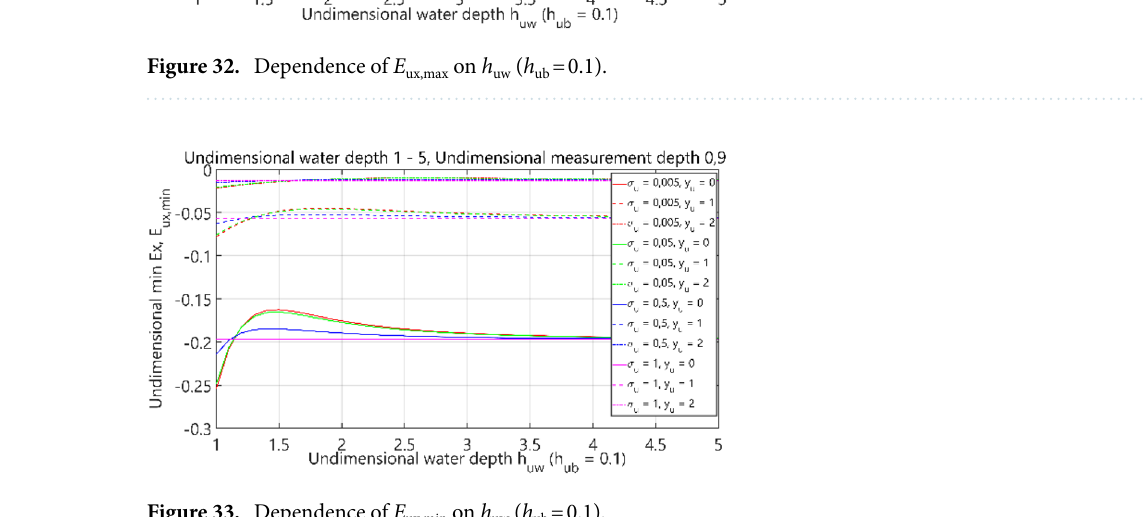
Figure 33. Dependence of E ux,min on h uw ( h ub = 0.1).